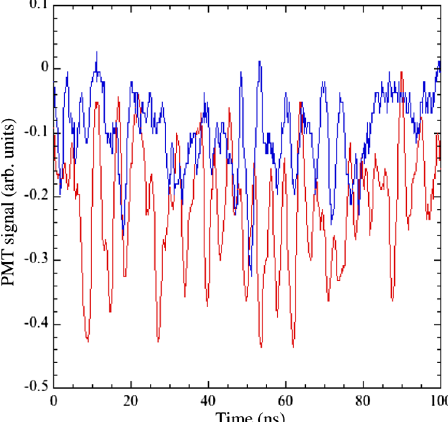
FIG. 12. The time evolution of visible light from an rf arc in an accelerator cavity during breakdown. The red trace shows the conditions with B ¼ 0 and the blue trace shows the trace with a solenoidal field of B ¼ 3 T . Many experiments have seen similar behavior